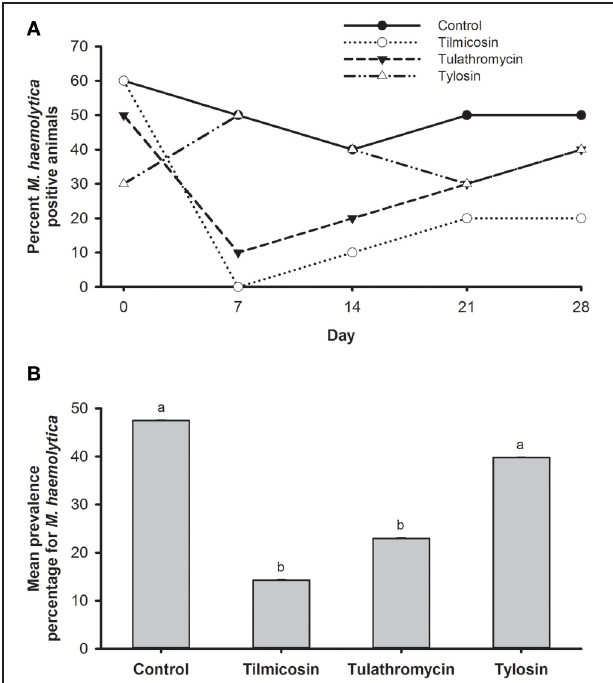
FIGURE 3 | (A) Percentage of animals positive for M. haemolytica for each of the five sampling events over 28 days study period. (B) Mean percentage of M. haemolytica prevalence in animals over the entire study period. Means with different superscripts differ ( P < 0 . 05).